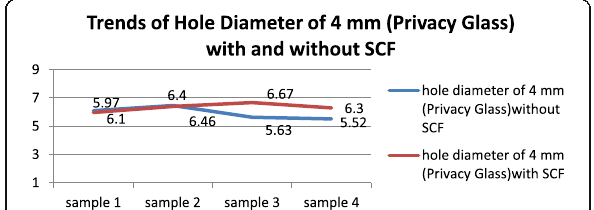
Fig. 12 Graphical Representation of Hole diameter of 4 mm Privacy Glass Pane with and without